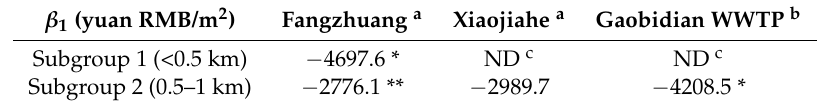
Table 4. Comparison of β 1 for WWTPs in Beijing.